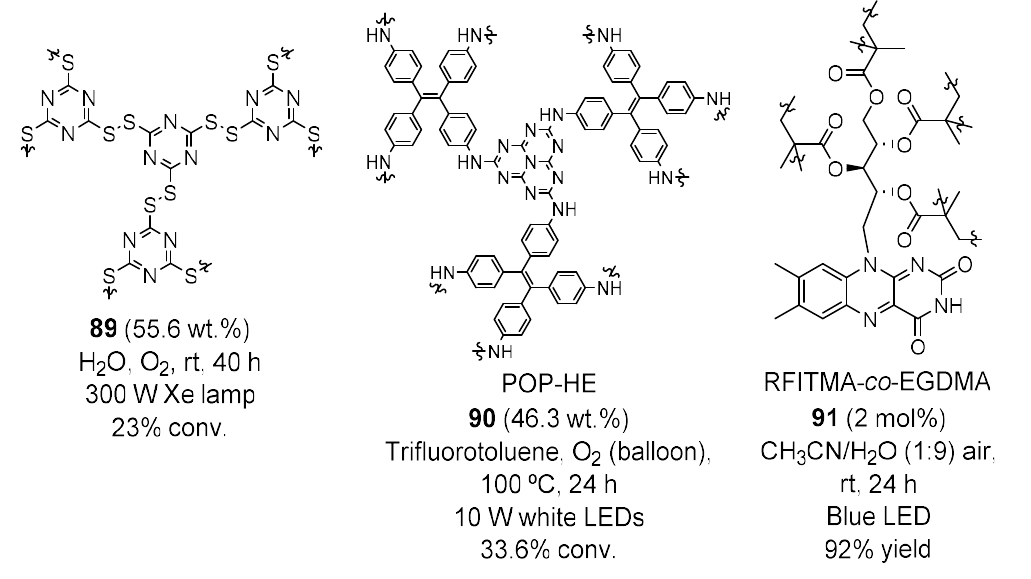
Figure 25. Results obtained in the aerobic photo-oxidation of benzyl alcohol to benzaldehyde catalyzed by 89 – 91 .